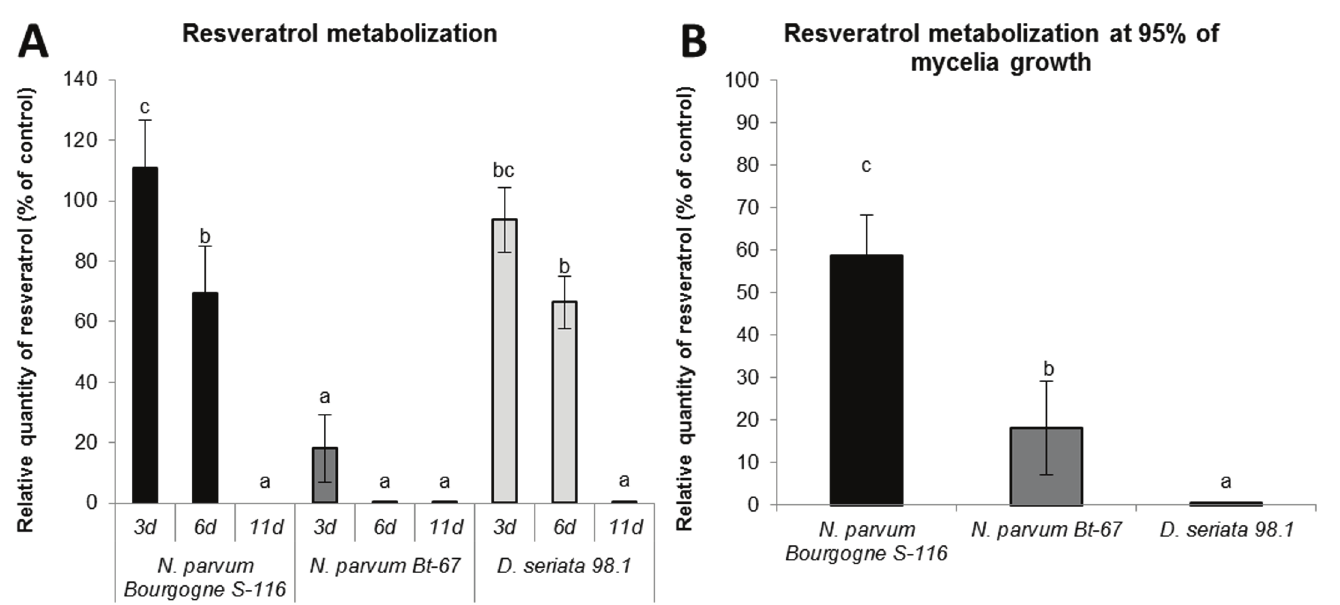
Fig 6. Resveratrol metabolization by Botryosphaeriaceae fungi. Resveratrol (initiallyaddedat 50 μ M) was quantifiedby LC-MS in PDA medium extract of N . parvum BourgogneS-116, N . parvum Bt-67 and D . seriata 98.1. The resveratrol quantity is expressedin relative quantity (% of control) comparedto control medium without fungi at different time points (3, 6 and 11 days; A), or when fungi have saturated 95% of the Petri Dish surface (B). Values are means and SD of three biological replicates, each calculatedfrom the mean of three technicalreplicates. Means with a same letter are not significantly different at p (cid:20) 0.05(Tukey